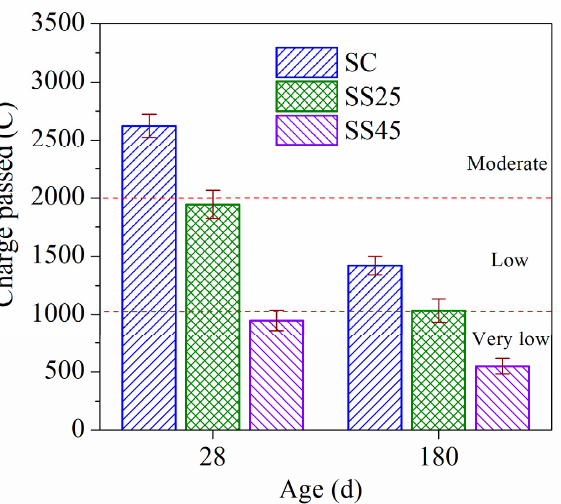
Figure 4. Chloride ion penetrability resistance of high-strength concrete under standard curing